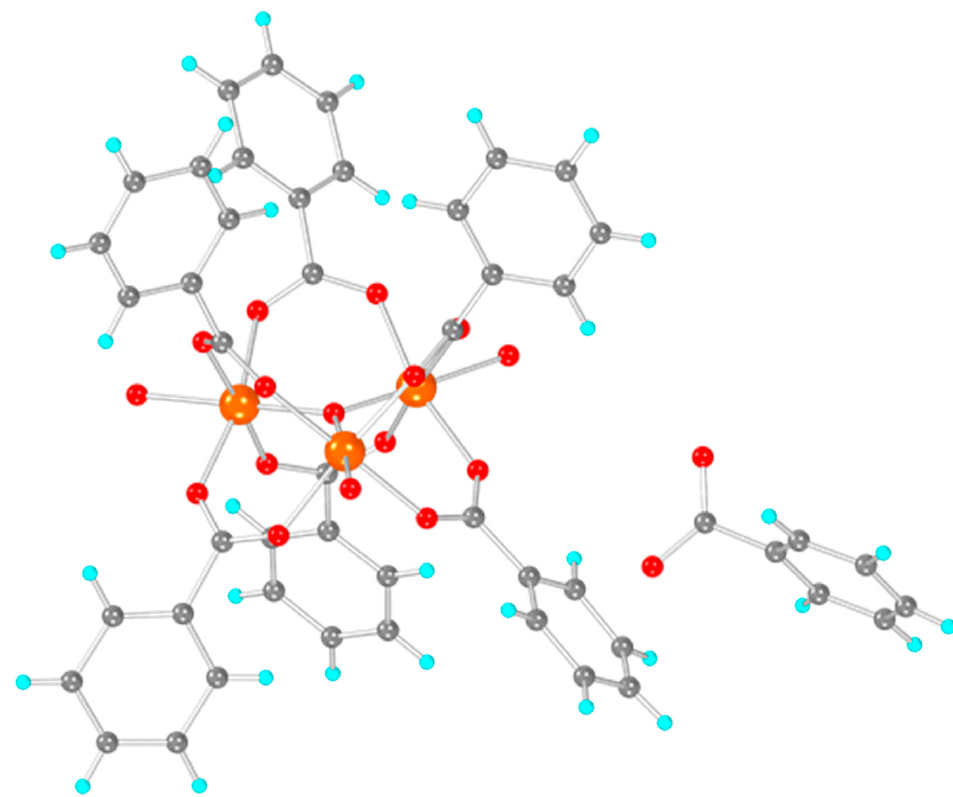
Figure 2. Structure of [Fe 3 O(PhCO 2 ) 6 (H 2 O) 3 ] · PhCO 2 solved by powder X-ray diffraction. Colour code: Fe: orange, C: grey, H: turquoise, O: red.